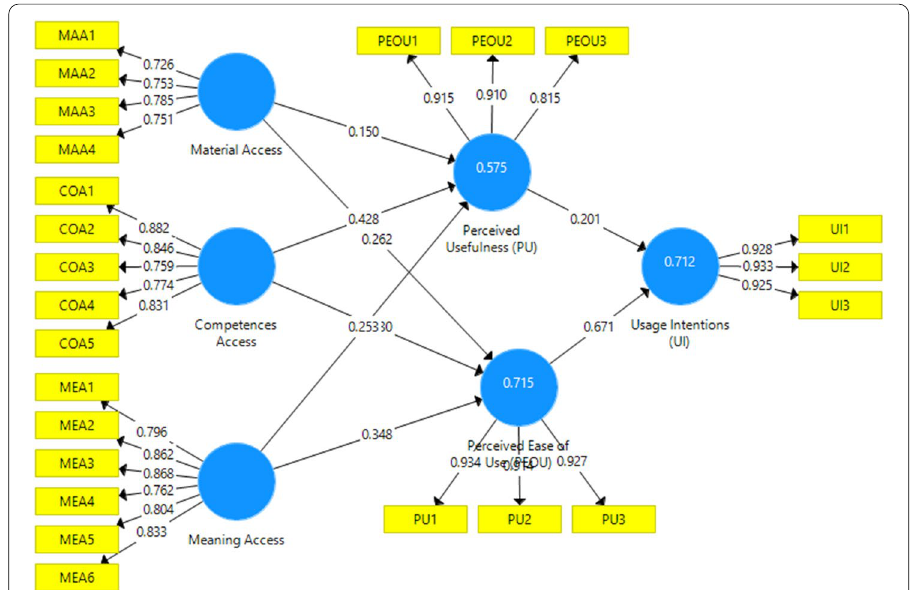
Fig. 2 PLS algorithm estimates (Loading and Coefficients)